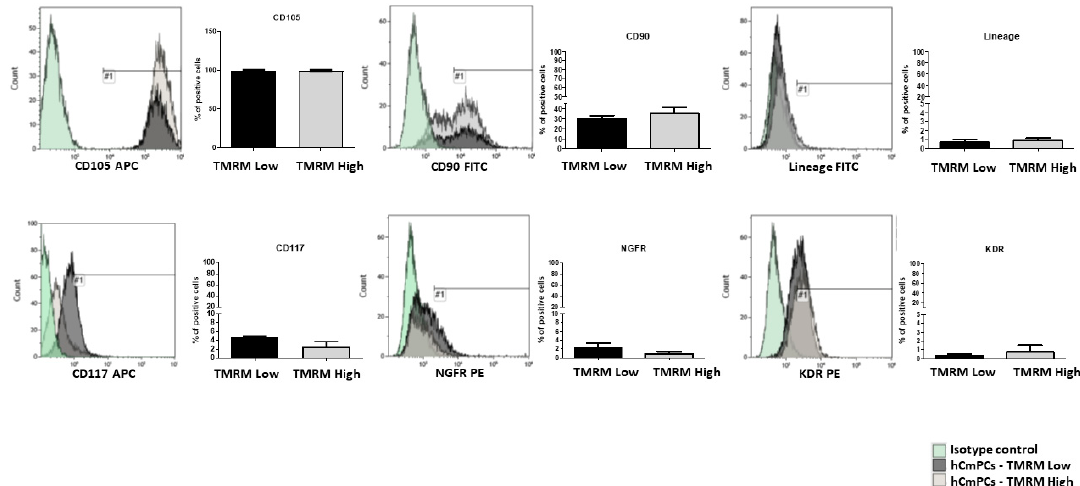
Figure 1. Characterization of tetramethylrhodamine methyl ester (TMRM)-low and TMRM-high cell populations by fluorescent activated cell sorting (FACS) analysis. Bar graphs shows the expression of the mesenchymal markers CD105, CD90 and Lineage (CD2, CD3, CD11b, CD14, CD15, CD16, CD19, CD56, CD123, and CD235a), the stem cells markers CD117 and nerve growth factor receptor (NGFR) and the endothelial marker vascular endothelial growth factor receptor 2 (VEGFR-2) / kinase insert domain receptor (KDR) in human cardiac mesenchymal progenitor cells (hCmPCs) sorted by TMRM-low and high expression. Data are represented as mean ± SD. n = 3 per group.